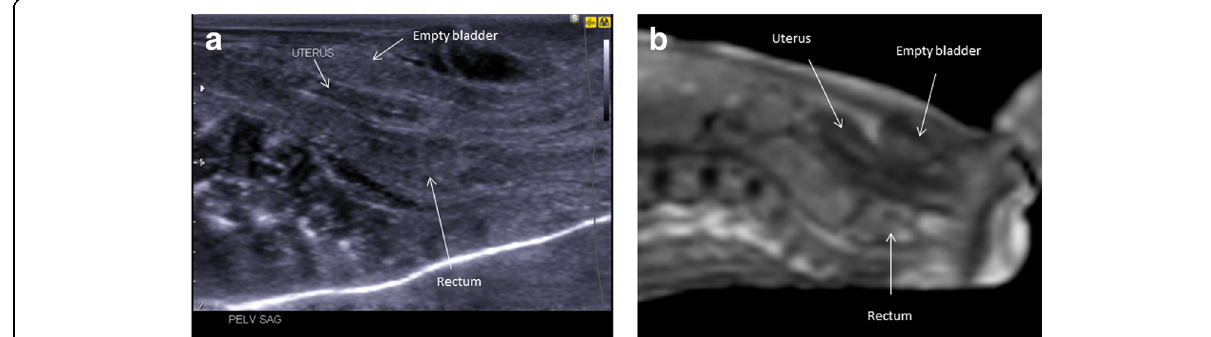
Fig. 19 These images demonstrate normal appearances of the pelvic structures in a female 18-week gestational-aged foetus. Sagittal postmortem ultrasound of the pelvis ( a ) and corresponding postmortem T2-weighted MRI at 1.5 T ( b ) have been obtained 12 days after death. The tubular appearances of a normal pre-pubertal uterus, rectum and urinary bladder are all well seen and labelled in these images. Using a high-frequency linear probe, the pelvic anatomy can be better demonstrated on ultrasound rather than